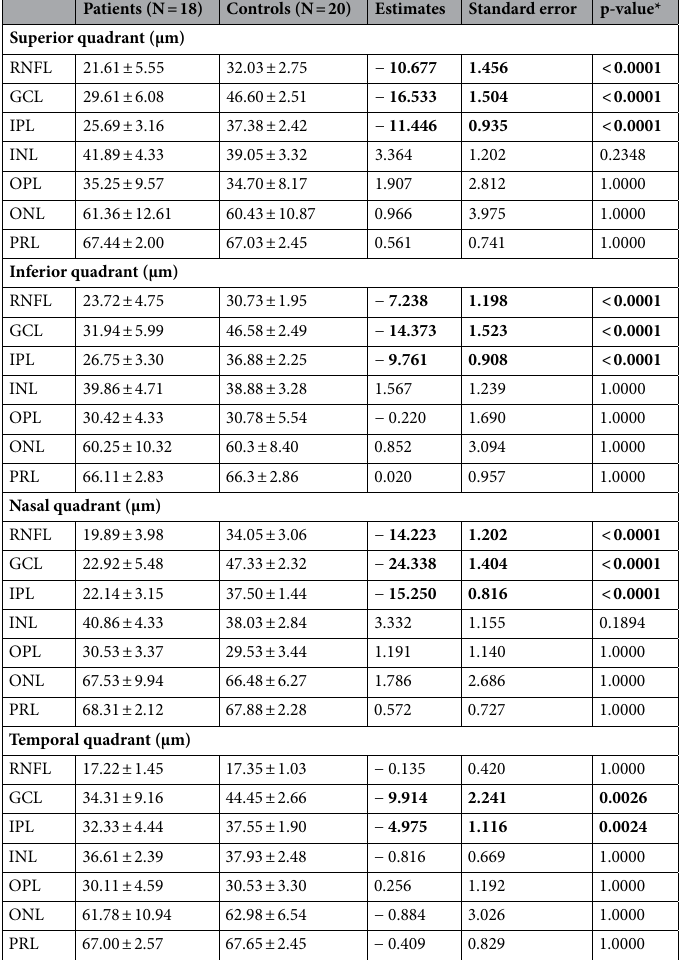
Table 2. Comparison of intraretinal layer thickness between pediatric and juvenile craniopharyngioma patients and healthy controls. Significant values are indicated in bold. N numbers, RNFL retinal nerve fiber layer, GCL ganglion cell layer, IPL inner plexiform layer, INL inner nuclear layer, OPL outer plexiform layer, ONL outer nuclear layer, PRL photoreceptor layer. * P -values obtained by linear regression were adjusted for age and SE and Bonferroni’s correction multiplied by